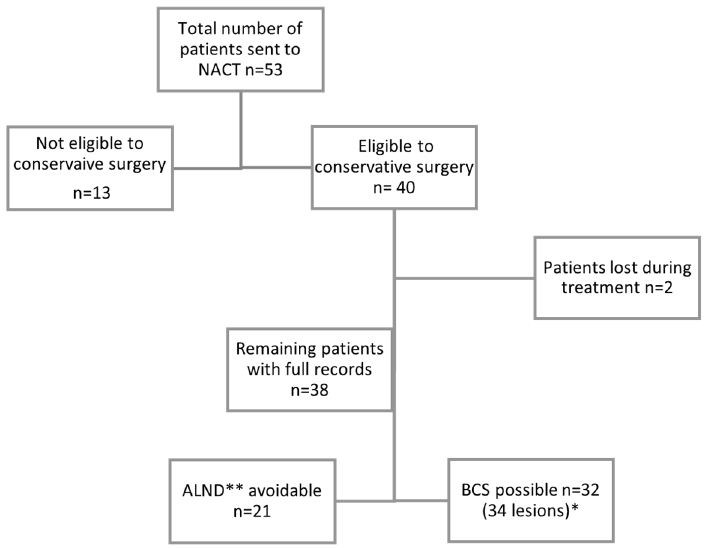
Figure 2. Study population. * Two patients had bilateral disease eligible to BSC, ** axillary lymph node dissection. Table 1. Number and localization of